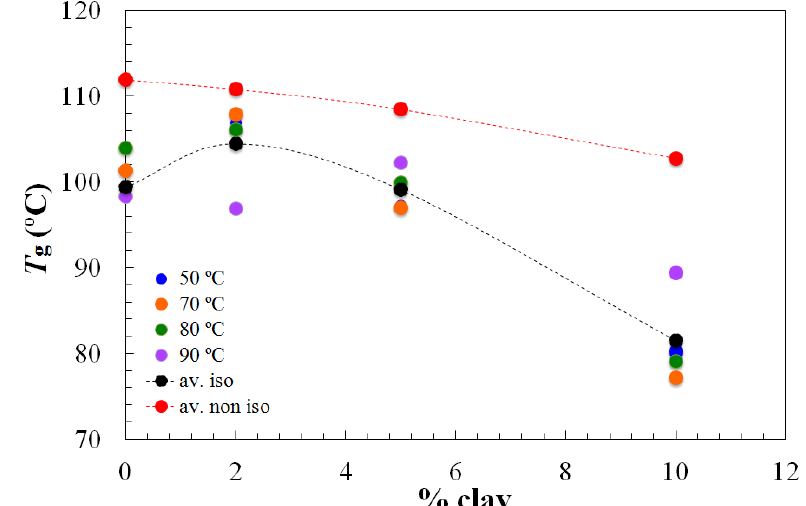
Figure 4. The dependence of the glass transition temperature of the fully cured samples, T , on clay content, for the isothermal cure of nanocomposites with Lupasol HBP at the g ∞ isothermal temperatures indicated. The black dotted line represents the average value for each percent of clay content; the red dotted line represents the average values for the non-isothermal cure experiments on the same